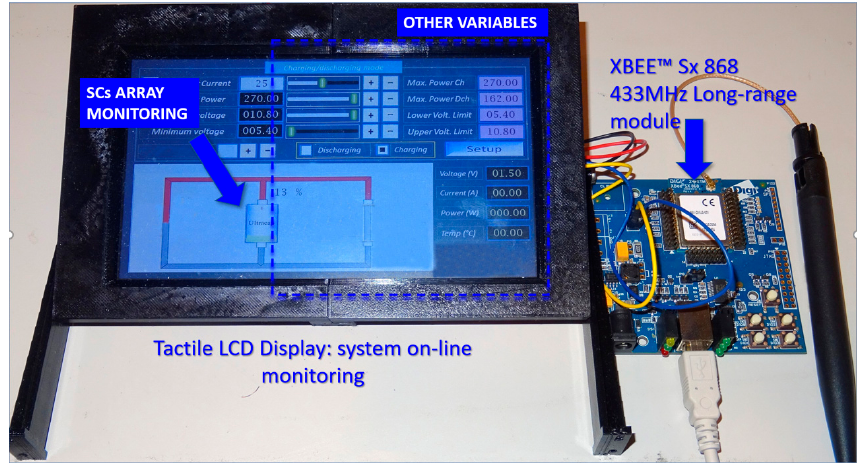
Figure 24. Present level of development of the monitoring system.